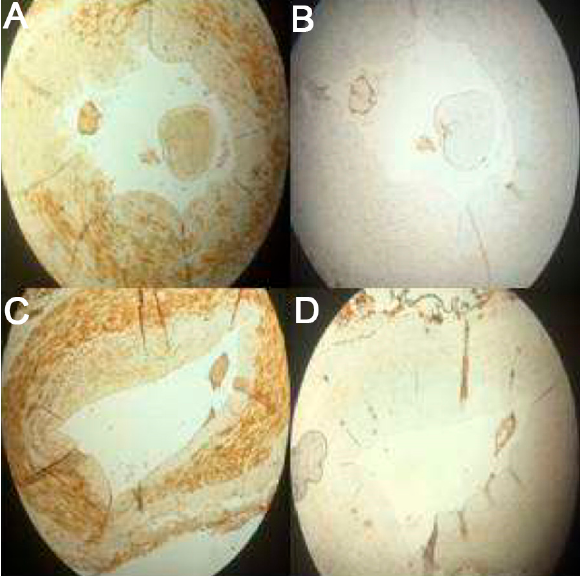
Figure 1. Immunohistochemistry on the radial artery wall, showing expression of OPG ( A , C ) and RANKL ( B , D ) of healthy controls and CKD patients, respectively.